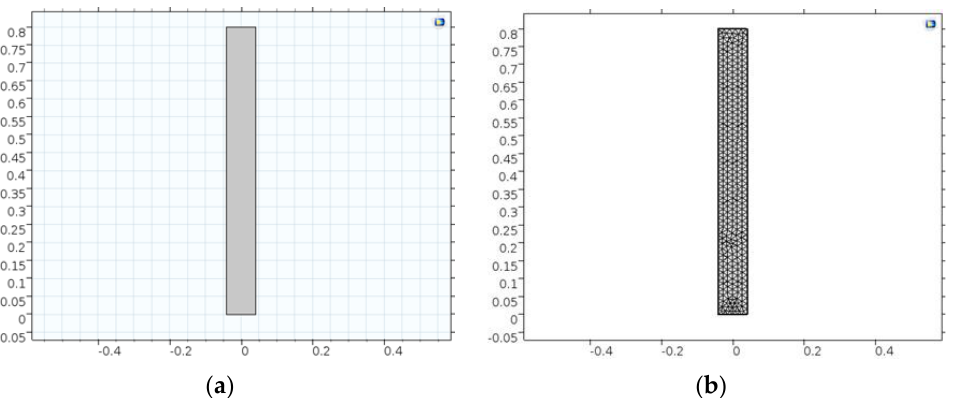
Figure 2. Computational domain of the fixed bed column for numerical simulations: ( a ) 2D geome- try of the fixed-bed adsorption column developed using COMSOL; ( b ) meshed domain of the de- veloped geometry.